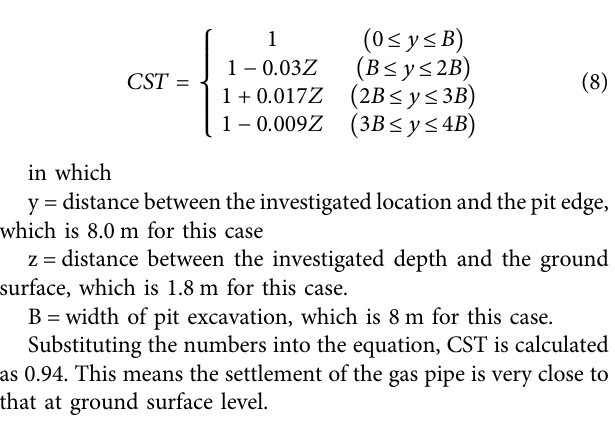
Compression modulus E s1-2